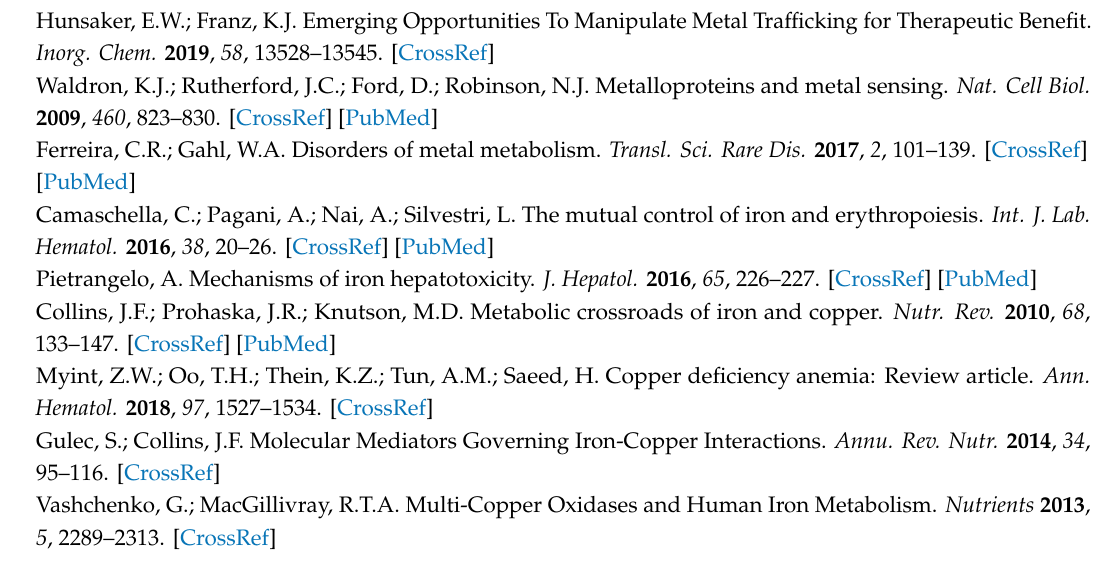
Figure S1: Genes in the Kyoto Encyclopedia of Genes and Genomes (KEGG) pathway of cholesterol metabolism predicted to carry iron response elements. Predictions with high, medium, and low confidence are shown in yellow, blue, and orange, respectively. Figure S2: Genes in the KEGG pathway of fatty acid degradation predicted to carry iron response elements. Predictions with high, medium, and low confidence are shown in yellow, blue, and orange, respectively. Table S1: STROBE Statement Checklist of items that should be included in reports of observational studies. Table S2: The number of phenotypes and cases considered in each disease category. Table S3: Descriptive characteristics of the UK Biobank participants and the SNPs included in PheWAS analyses. Table S4: The association between the weighted polygenic risk score of each blood mineral and common confounding factors. Table S5: List of shared and unique outcome–exposure pairs exhibiting consistent MR evidence for causal e ff ects. Table S6: Multivariate IVW MR results for iron and copper. Table S7: The results of leave-one-out MR analysis. Table S8: Lists of mineral–outcome relationships based on sex-stratified MR